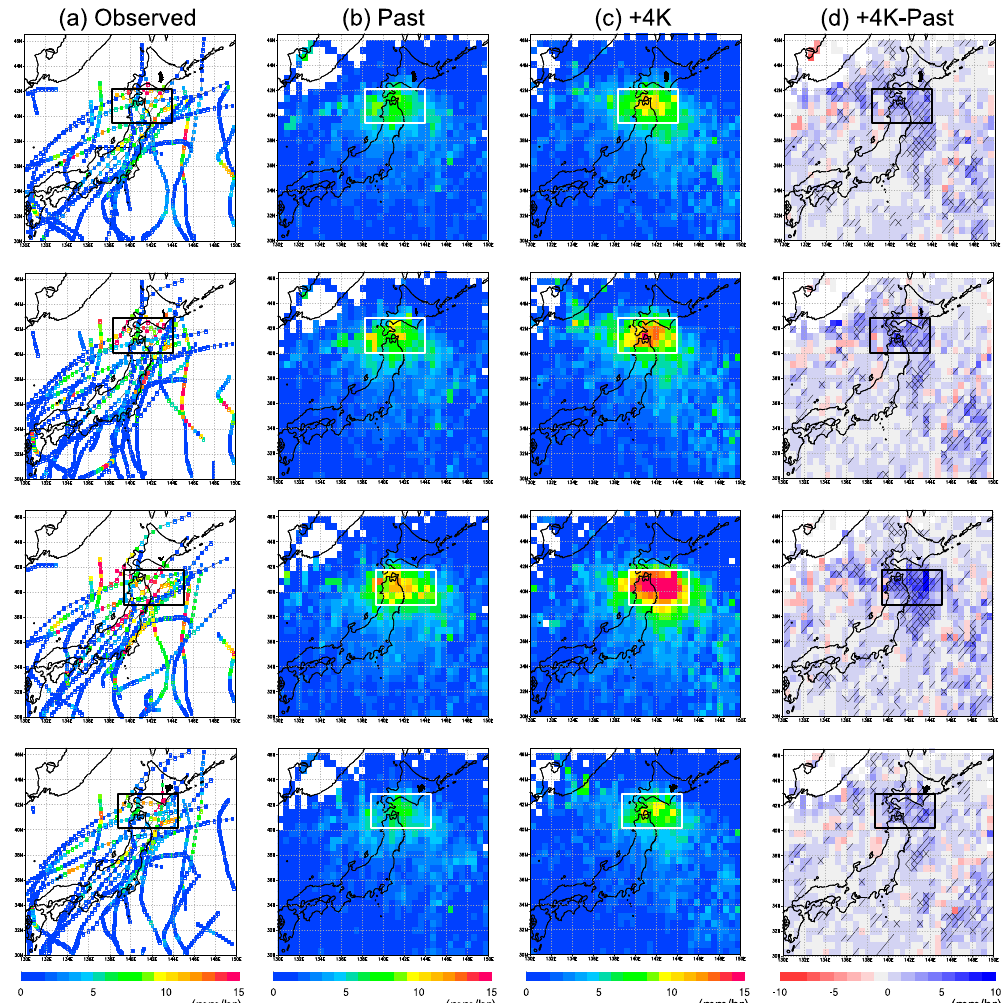
Figure 3. Area-averaged rainfall intensity over the sub-basins at the TC position. From the left: ( a ) Observed data (1976–2018), ( b ) past experiment, ( c ) +4K experiment, and ( d ) +4K experiment minus past experiment (diagonal lines (upper right to lower left) represent grids that satisfy a 5% significance level using Welch’s t-test, diagonal lines (upper left to lower right) represent grids on which rainfall intensifies under the all six sea surface temperature patterns from the +4K experiment). From the top: area-average rainfall over the TKC basin, OTF basin, STN basin, and TSB basin. The black fills indicate the target basins. The solid line boxes indicate the hotspot for each basin; the TKC basin (138.40° E–144.00° E, 39.52° N–42.32° N), OTF basin (138.40° E–144.00° E, 40.08° N–42.88° N), STN basin (139.52°